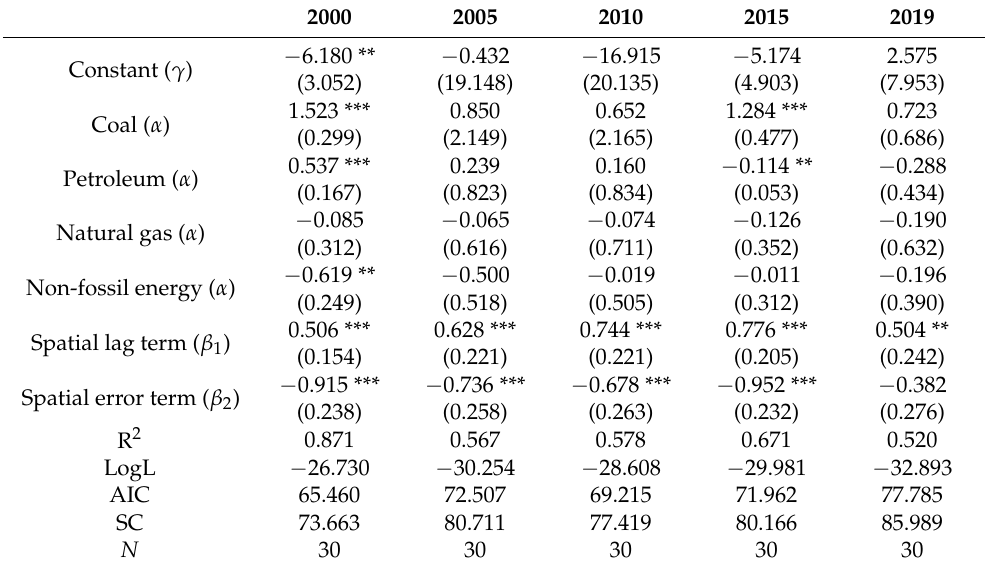
Table 3. Spatial regression results for total CO 2 emissions in China (five-time sections), based on the SEMLD model.